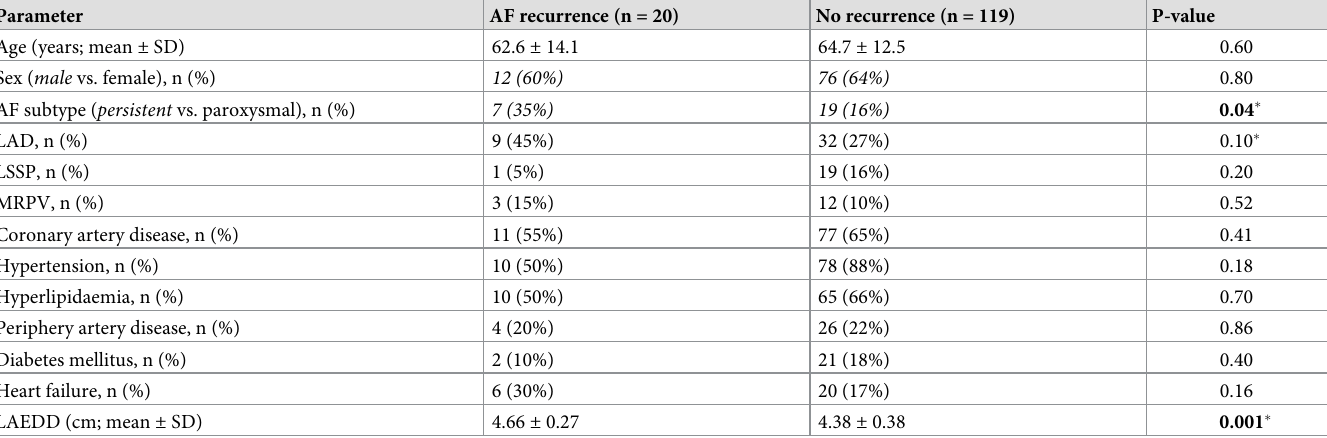
Table 1. Patient characteristics with and without AF